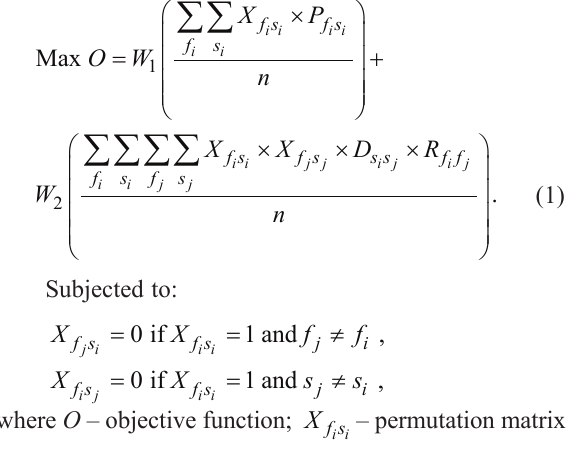
Movementpattern